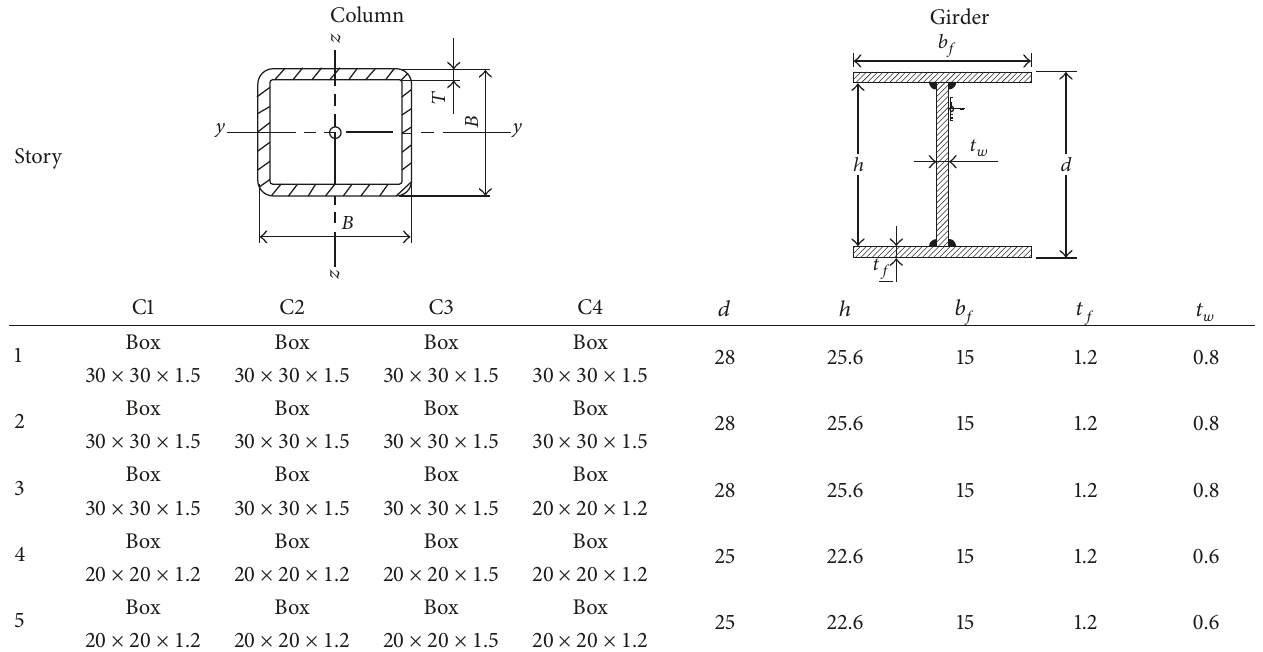
Table 8: Sections for the 5-story steel